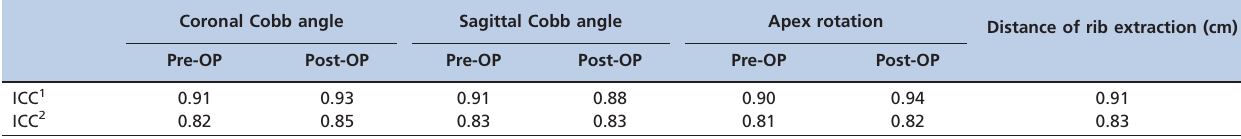
Table 3 - Reliability tests of measured parameters. Coronal Cobb angle Sagittal Cobb angle Apex